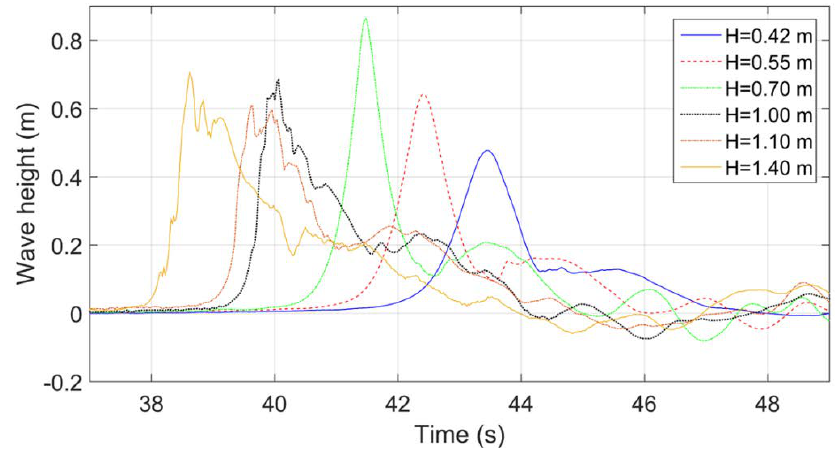
Figure 5. Wave heights recorded at wg12 for three selected unbroken solitary waves and three bores. Table 1. Wave matrix used in the experimental testing of the bridge with steel bearings. Water Depth